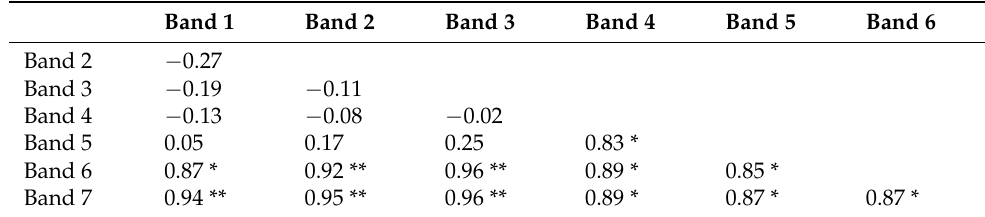
Table 5. Correlation (r) between aboveground carbon content of J. kraussii quadrats with each normalized difference (ND) ArborCam image (* p < 0.05; ** p < 0.01). Band